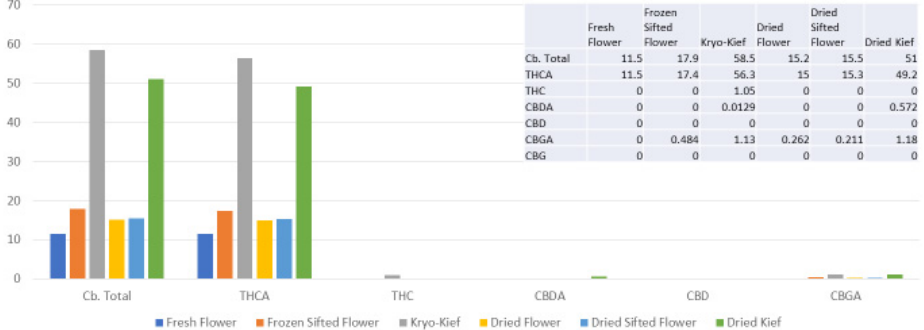
Figure 6. Tangie Biscotti Type I chemovar cannabinoid assay results (all figures are %).